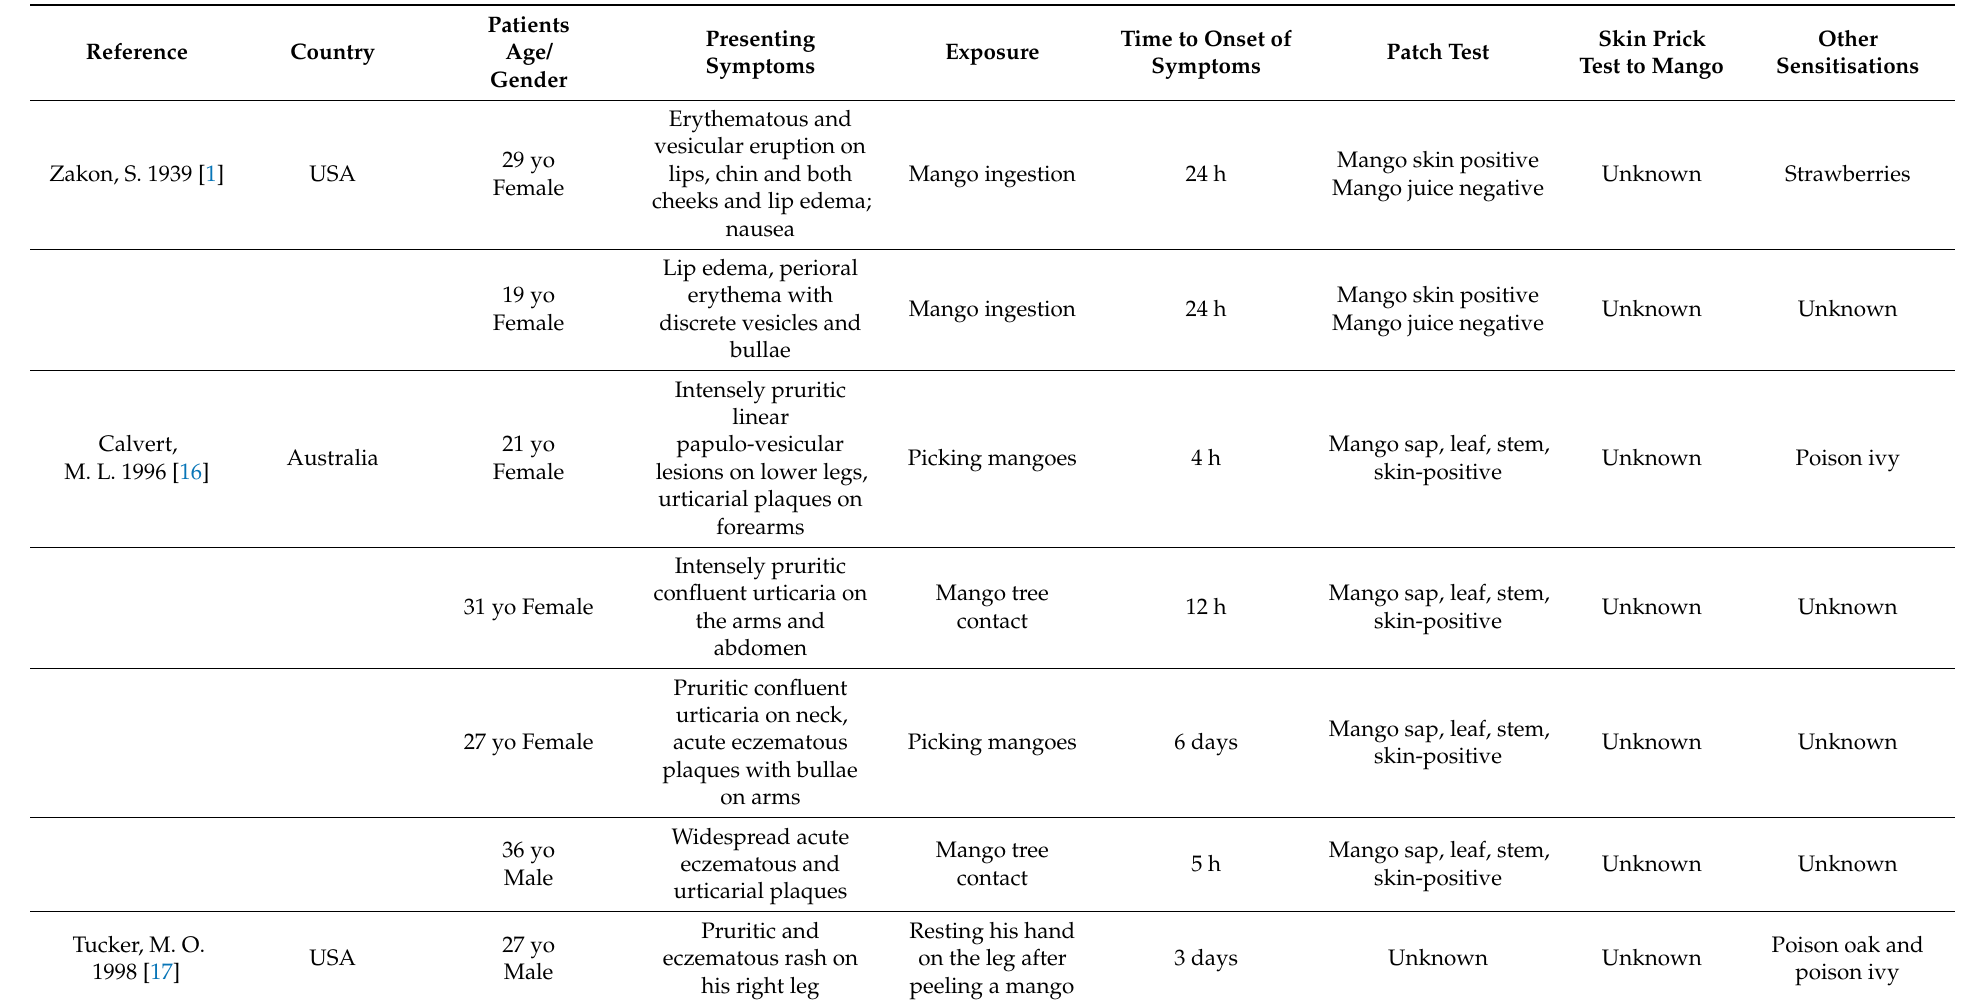
Table 2. Published cases of mango-induced contact